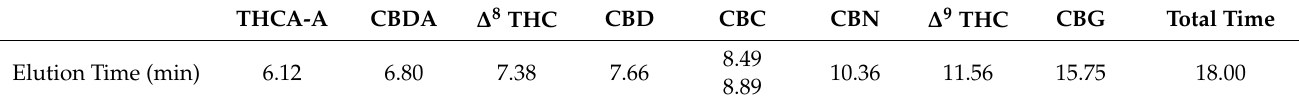
Table 3. Elution times for 10-cannabinoid normal-phase separation on Chiralpak IB-U.